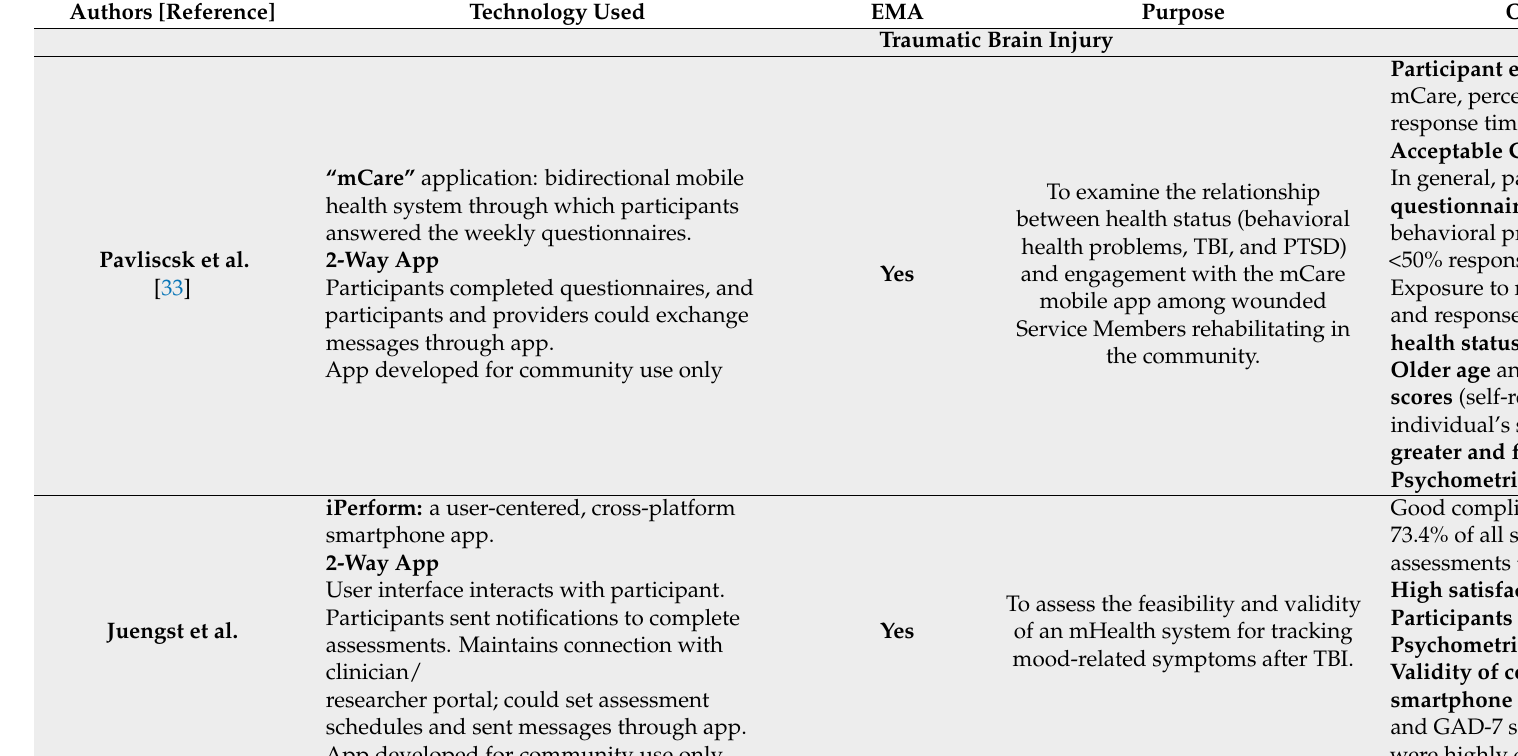
Table 2. Mobile Health Study